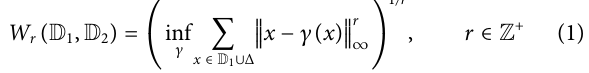
Frontiers in Environmental Science |